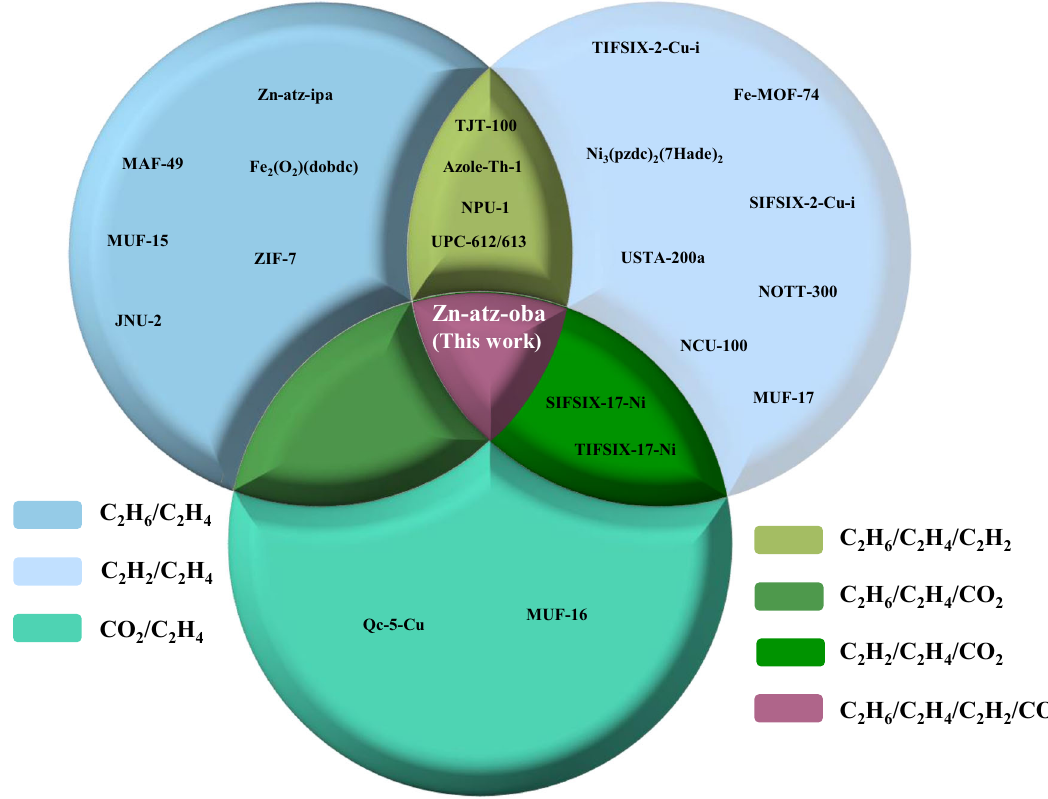
Fig. 5 Physisorbents studied for C 2 H 4 puri fi cation. Comparison of physisorbents that can purify C 2 H 4 from binary (sky blue) 15 – 20, 22 – 30, 32, 46 , ternary (olive green) 35, 36, 39 – 41 and quaternary mixtures (lilac, this work) under ambient